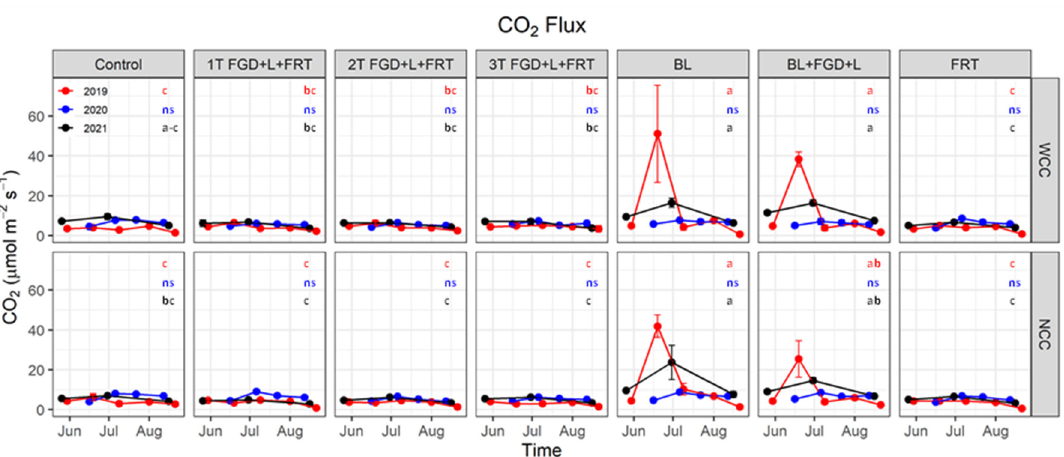
Figure 5. Soil CO 2 flux. Red, blue and black lines represent soil CO 2 flux in 2019, 2020 and 2021, respectively. Solid cycles are the mean of replicates, and error bars are standard errors (n = 3). Red, blue and black letters show the results of Tukey’s multiple comparison tests for 2019, 2020 and 2021, respectively, with no letter in common denoting significant differences at α = 0.05 (ns: no significant difference). WCC: with cover crop; NCC: no cover crop.